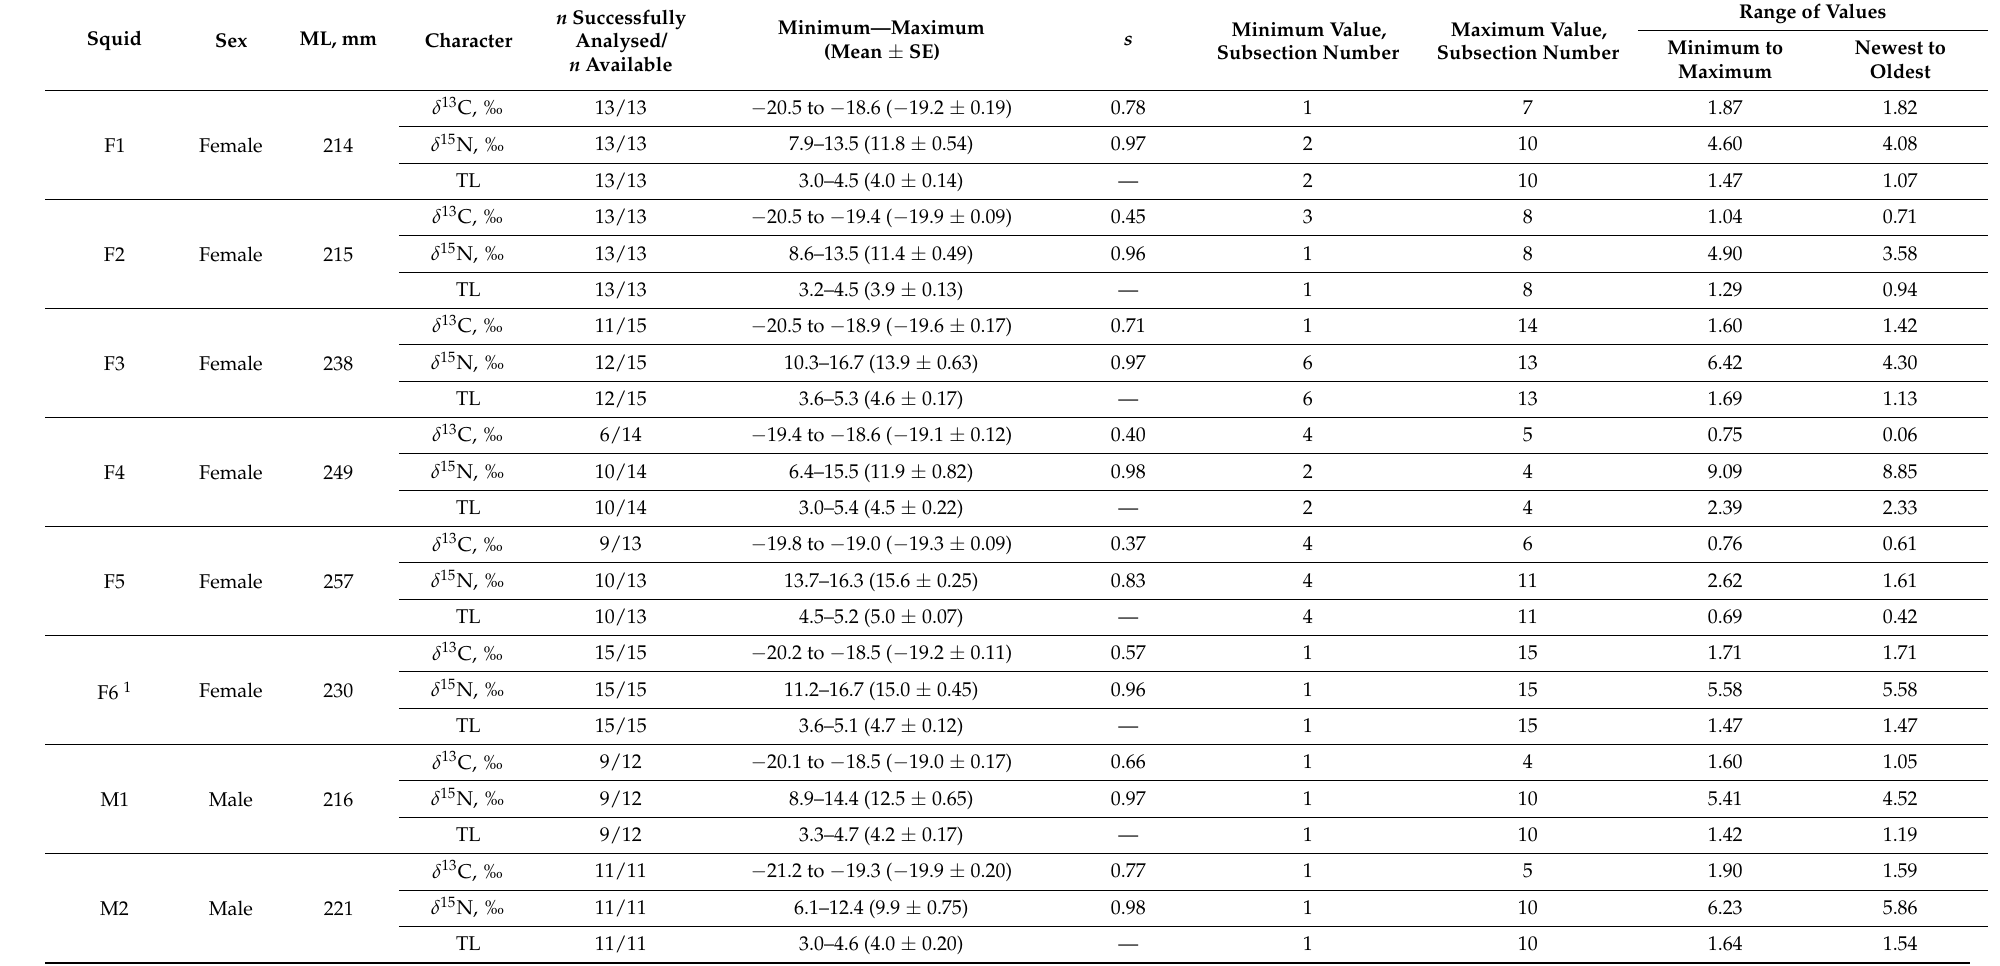
Table 1. Values of δ 13 C and δ 15 N, estimated trophic level, and specialization index of all analysed individuals of Gonatus fabricii ( n = 14), and mean among the individuals, where applicable. ML: mantle length, TL: estimated trophic level, s : specialization index, n : sample size, n/a: not analysed, —: not